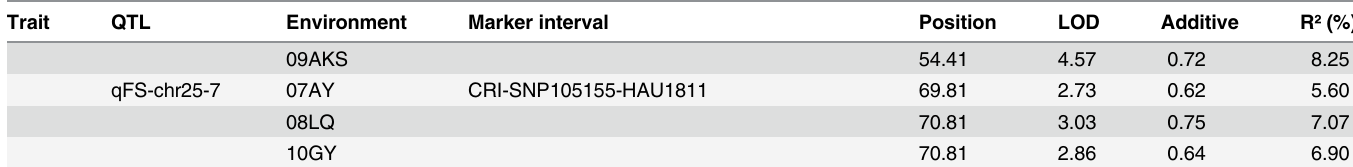
PLOS ONE | DOI:10.1371/journal.pone.0135430 August 11,